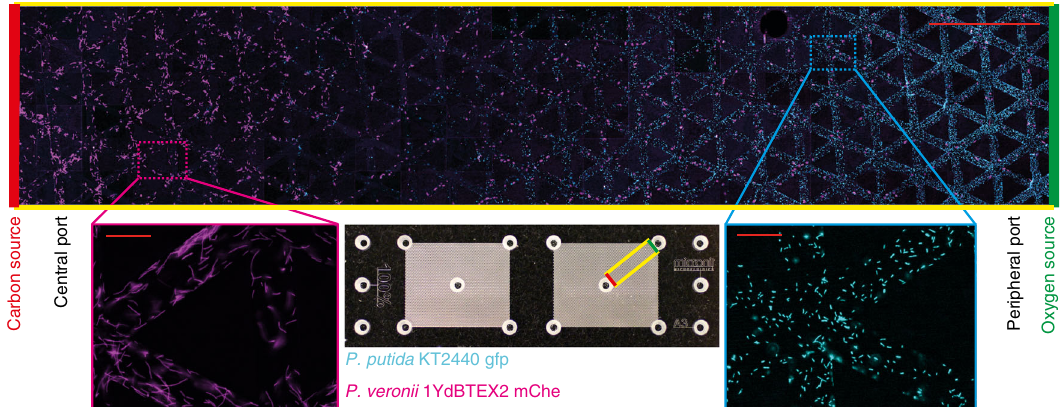
Fig. 3 Experimentally observed spatial segregation of bacterial populations in a micrometric pore network. The facultative anaerobic Pseudomonas veronii strain 1YdBTEX2-mChe is tagged with the mCherry fl uorescent protein and shown with pseudo-color magenta, and the obligate aerobic Pseudomonas putida strain KT2440-gfp is tagged with the eGFP fl uorescent protein and shown with pseudo-color cyan. The two species were mixed 1:1 in suspension and inoculated to the central port (total of ≈ 500 cells per species) of a pore network with a carbon source (citrate) located at the center and oxygen diffusing from the peripheral ports. Both species were able to disperse through the pore network by fl agellated motility. The exemplary overlay fl uorescence image (top) shows the distribution of the two bacterial populations in a transect across the 100% connected pore network (see inset) 1 week after inoculation (image contrast and brightness were enhanced for better visualization of the bacterial populations). The scale bar represents 500 μ m. The two close-up images show individual bacterial cells within one microscopy image, as used for digital image analysis and cell counting (each scale bar represents 40 μ m)